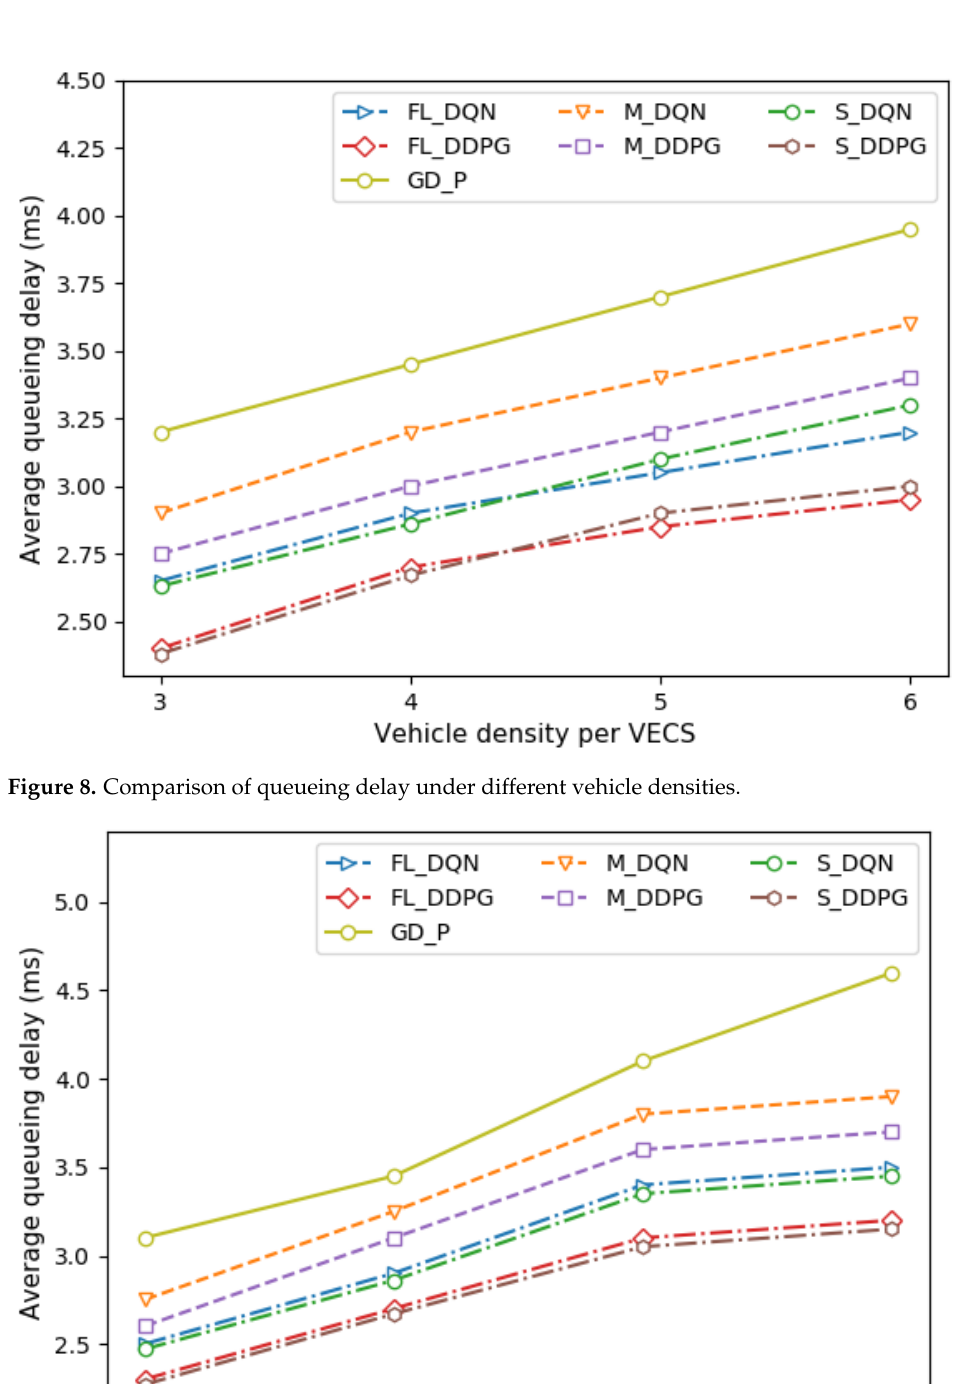
Figure 8. Comparison of queueing delay under different vehicle densities.